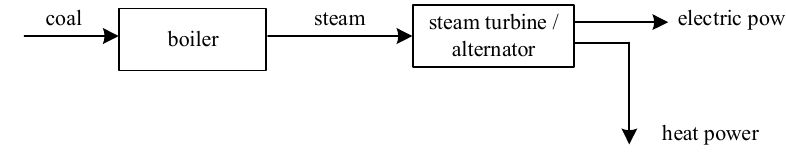
Figure 3. Mechanism of the back-pressure unit.